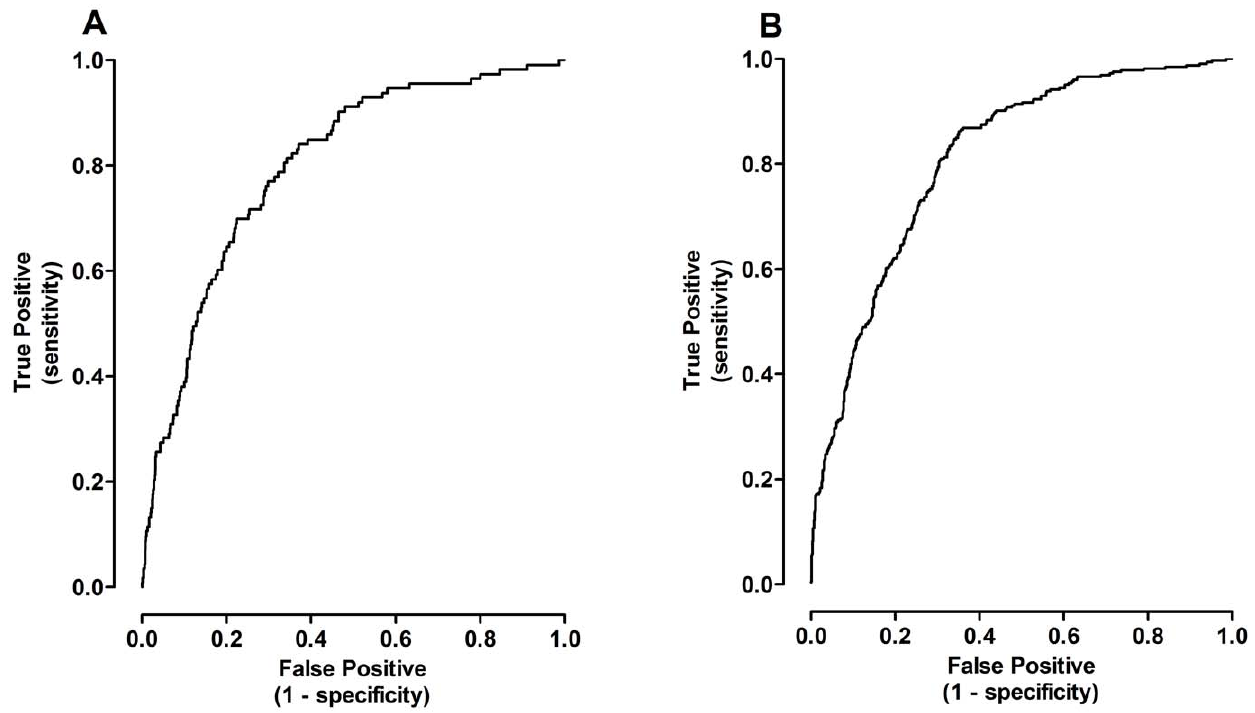
Figure 5. The receiver operating characteristic curve corresponding to a nominal logistical regression using body composition estimated by anthropometric modeling for subjects within the Endocrine Practice group (n=1153) is consistent with good detection of DM2 or MS. Similar to the DXA population, the ROCs are characterized by initial steep slopes indicating a high detection rate of true positives, but with a low false positive rate. A) The AUC for DM2 detection alone is 0.80 6 0.02 (1040 subjects negative, 113 positive; p , 0.0001). The 95% confidence interval of the AUC is 0.78 to 0.84. [Regression equation: k=0.14 + 0.18(Predicted FM) 2 0.59(Predicted TF) + 0.12(Predicted FFM)]. B) The AUC for detecting DM2 or MS is 0.81 6 0.01 (821 subjects negative, 332 positive; p , 0.0001). The 95% confidence interval is 0.78 to 0.84. [Regression equation: k=0.45 + 0.33(Predicted FM) 2 0.83(Predicted TF) + 0.06(Predicted FFM)].